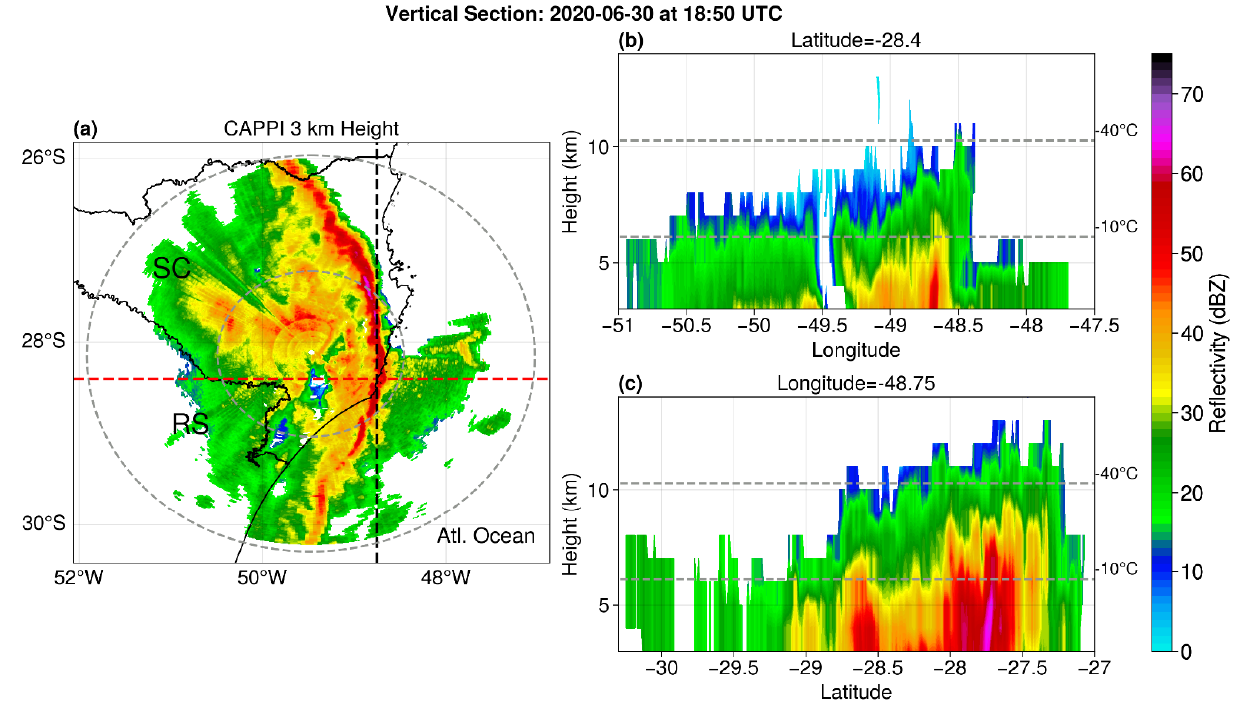
Figure 14. ( a ) Constant Altitude Plan Position Indicator (CAPPI) at 3 km height of reflectivity from Morro da Igreja radar at 1850 UTC and ( b , c ) vertical transversal section of the thunderstorm. The dashed red (black) line in figure ( a ) represents the latitude (longitude) section.